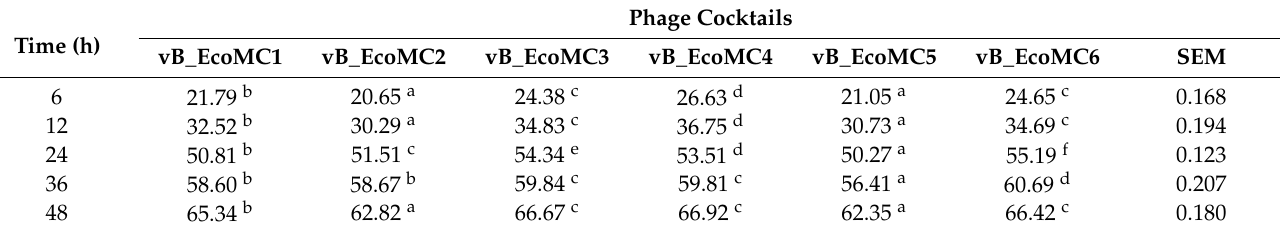
Table 4. Effect (% reduction) of phage cocktails on E. coli O177 cells in a rumen fermentation model.